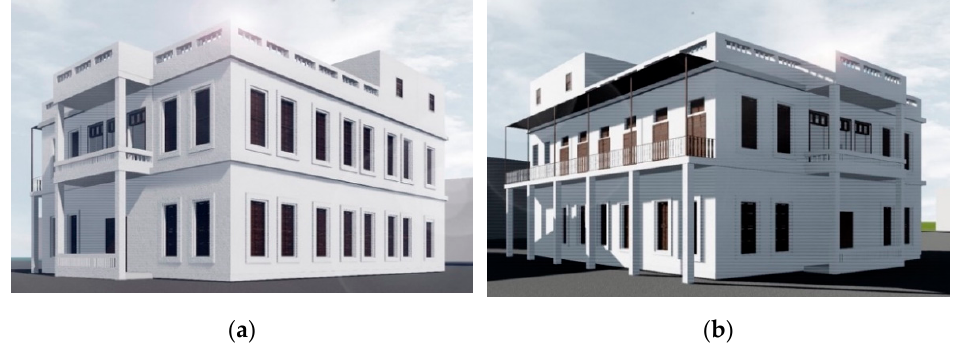
Figure 13. The 3D eBIM model of Zainal House. ( a ) shows the north-west elevation, and ( b ) shows the north-east elevation.